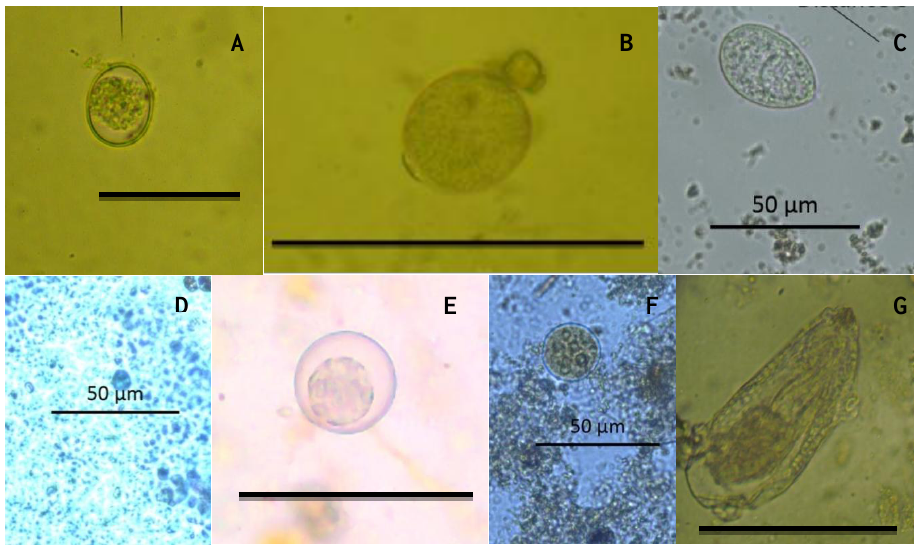
Figure 2 : Protozoan cysts in the faecal samples analysed from mammals in Dehiwela Zoo (A, B) coccidian oocysts (C) Cyst of Balantidium sp. (D) Cyst of Giardia sp. (E & F) Cysts of Entamoeba sp. (G) Unidentified protozoan cyst. (Scale bar = 50